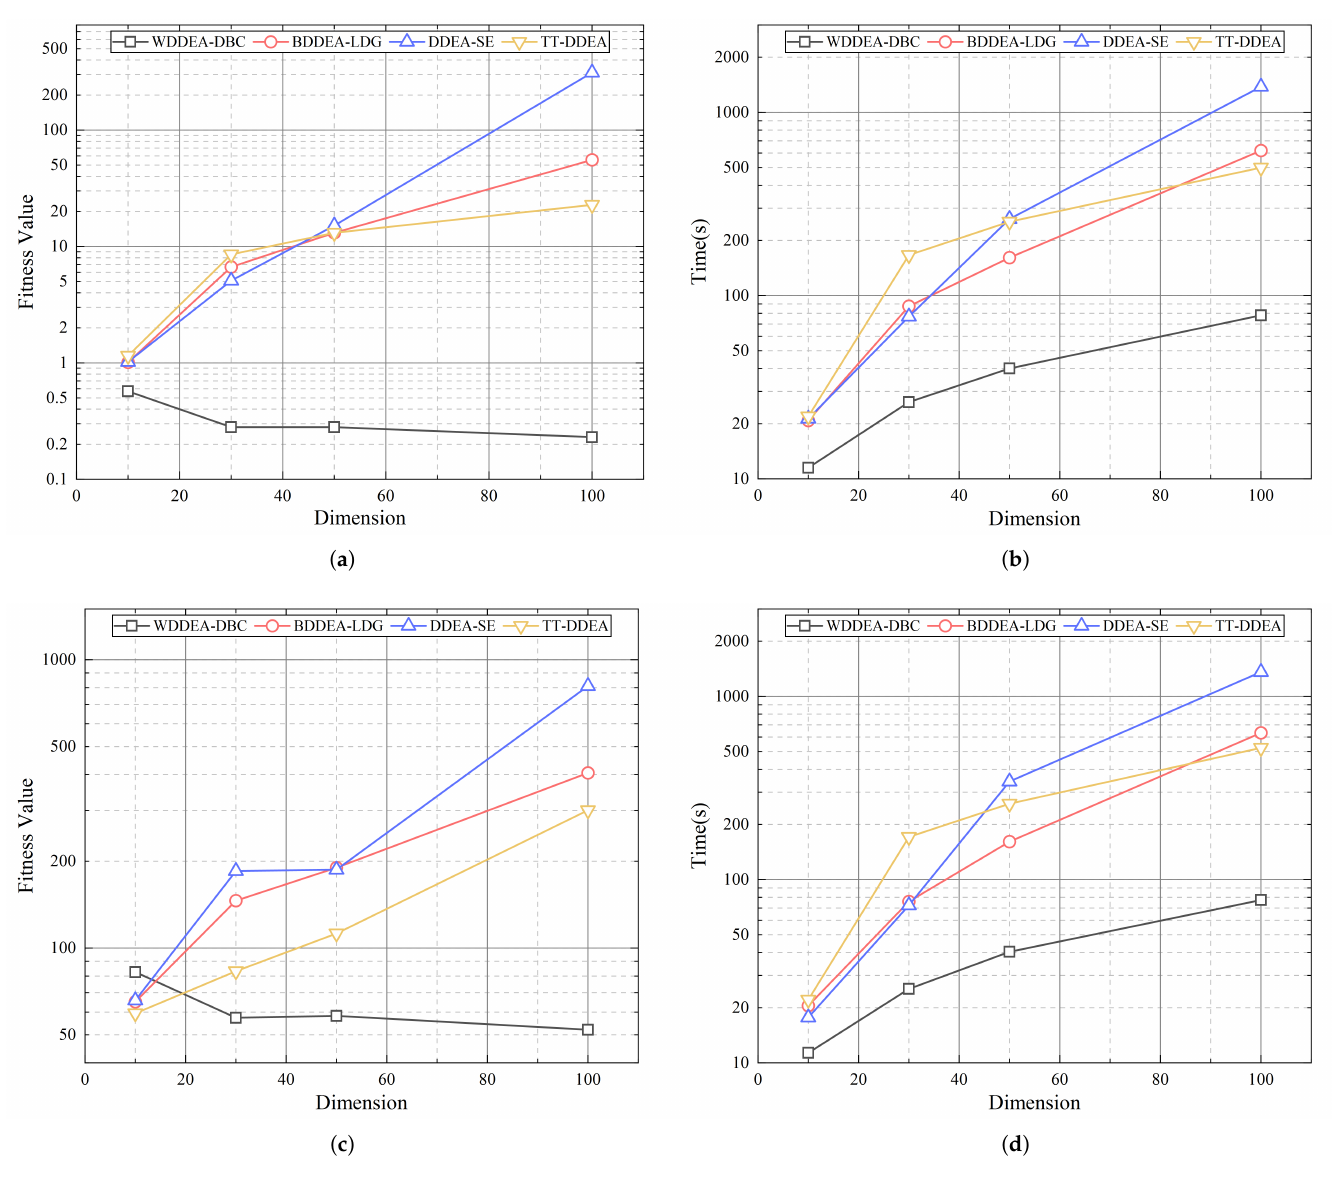
Figure 7. The fitness and time of the Ellipsoid function and the Rastrigin function change with dimension on different algorithms. ( a ) Fitness of the Ellipsoid function. ( b ) Time of the Ellipsoid function. ( c ) Fitness of the Rastrigin function. ( d ) Time of the Rastrigin